Question: Write a descriptive caption for this figure.
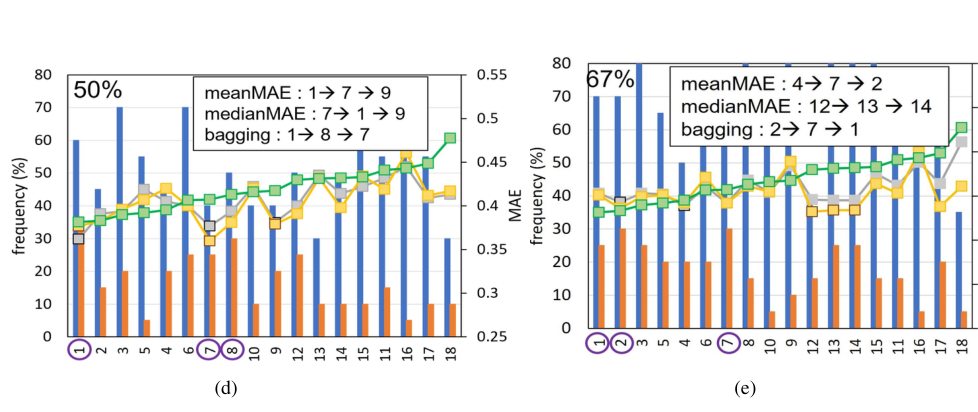
Answer: Comparison of random-search (RS) policies with grid-search (GS) for HP tuning: Ranked LSTM model configurations based on grid-search (a), showing all possible HP combinations for 18 models (b), frequency, top-k frequency, mean MAE and median MAE of HP configurations appearing in random-search iterations for (c) 35%, (d) 50%, (e) 67% sample size (top-3 models picked based on each policy are shown at top.